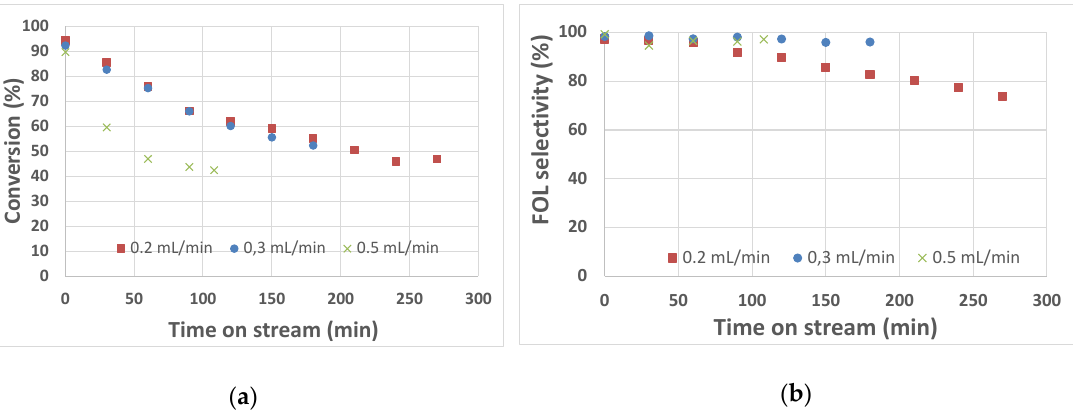
Figure 6. Effect of the alcoholic furfural solution (5 g of furfural in 45 g of ethanol) flow rate. 150 °C, 20 bar of hydrogen in the presence of 260 mg of Co/SiO 2 . ( a ) conversion vs. Time On Stream (TOS). ( b ) FOL selectivity vs . TOS.